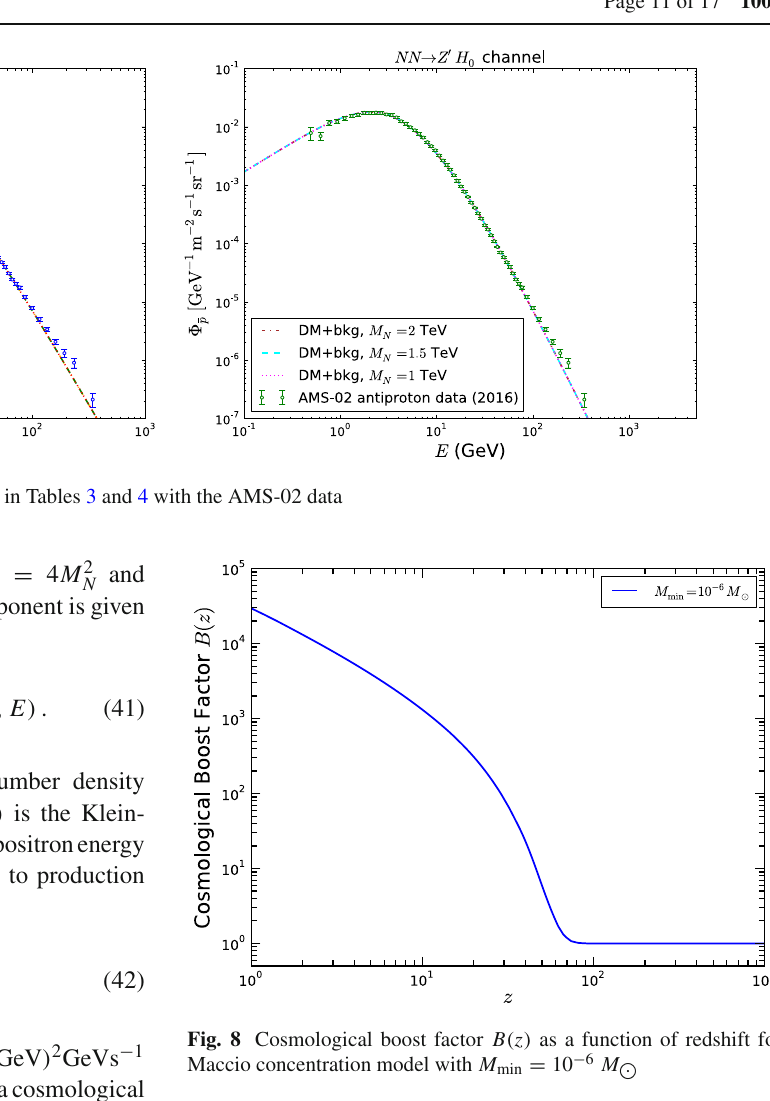
linear density field in spheres containing a mean mass M